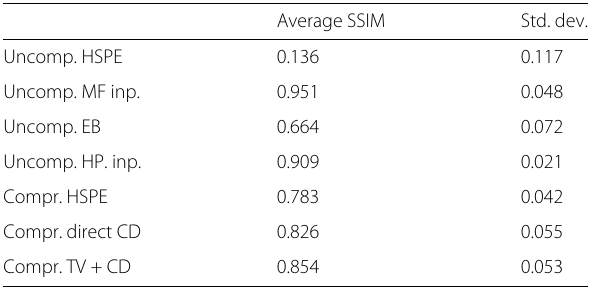
Table 3 Average SSIM scores with corresponding standard deviation for all inpainting methods along with the corresponding noisy frames Average SSIM Std.